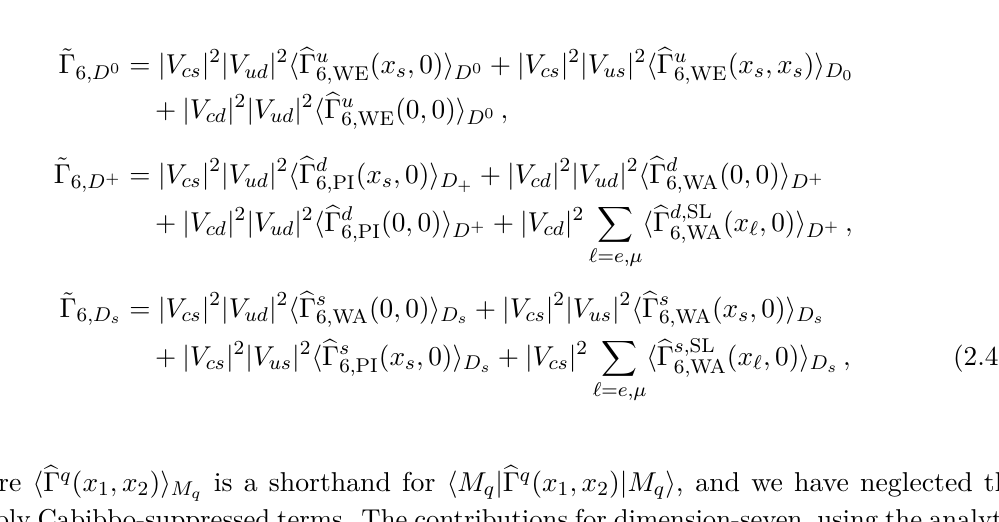
Table 3. Synopsis of various contributions of the four-quark operators to the lifetimes of singly charmed hadrons in the valence approximation, whereby the hierarchies stemming from various CKM scalings are denoted by CE (Cabibbo enhanced), SCS (singly Cabibbo suppressed), DCS (doubly Cabibbo suppressed). As before, NL and SL respectively denote nonleptonic and semileptonic contributions. The decay processes in the first row schematically denote the kinds of weak transitions appearing in the diagrams in figure 2, and are to be rearranged according to the quark involved in the